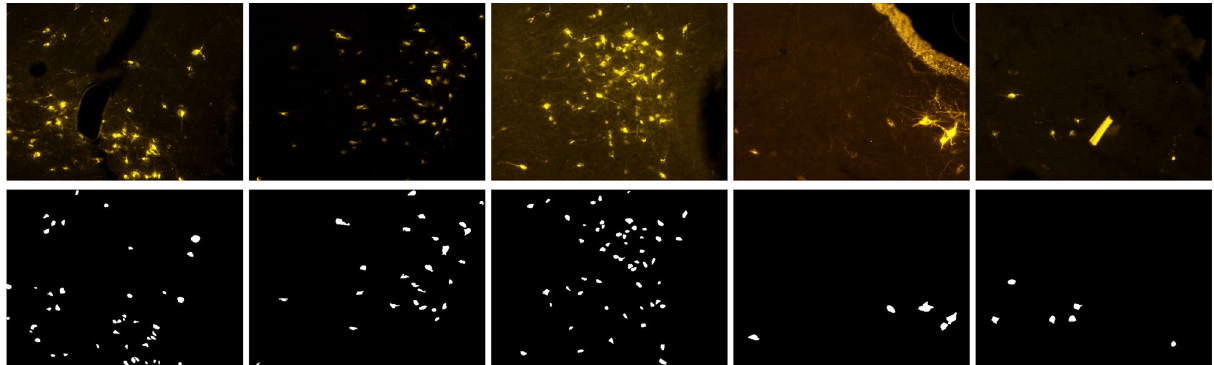
Figure 1. Sample data. The original images (top row) present neuronal cells of different shape, size and saturation over a background of variable brightness and color. The corresponding ground-truth masks used for training (bottom row) depict cells as white pixels over a black